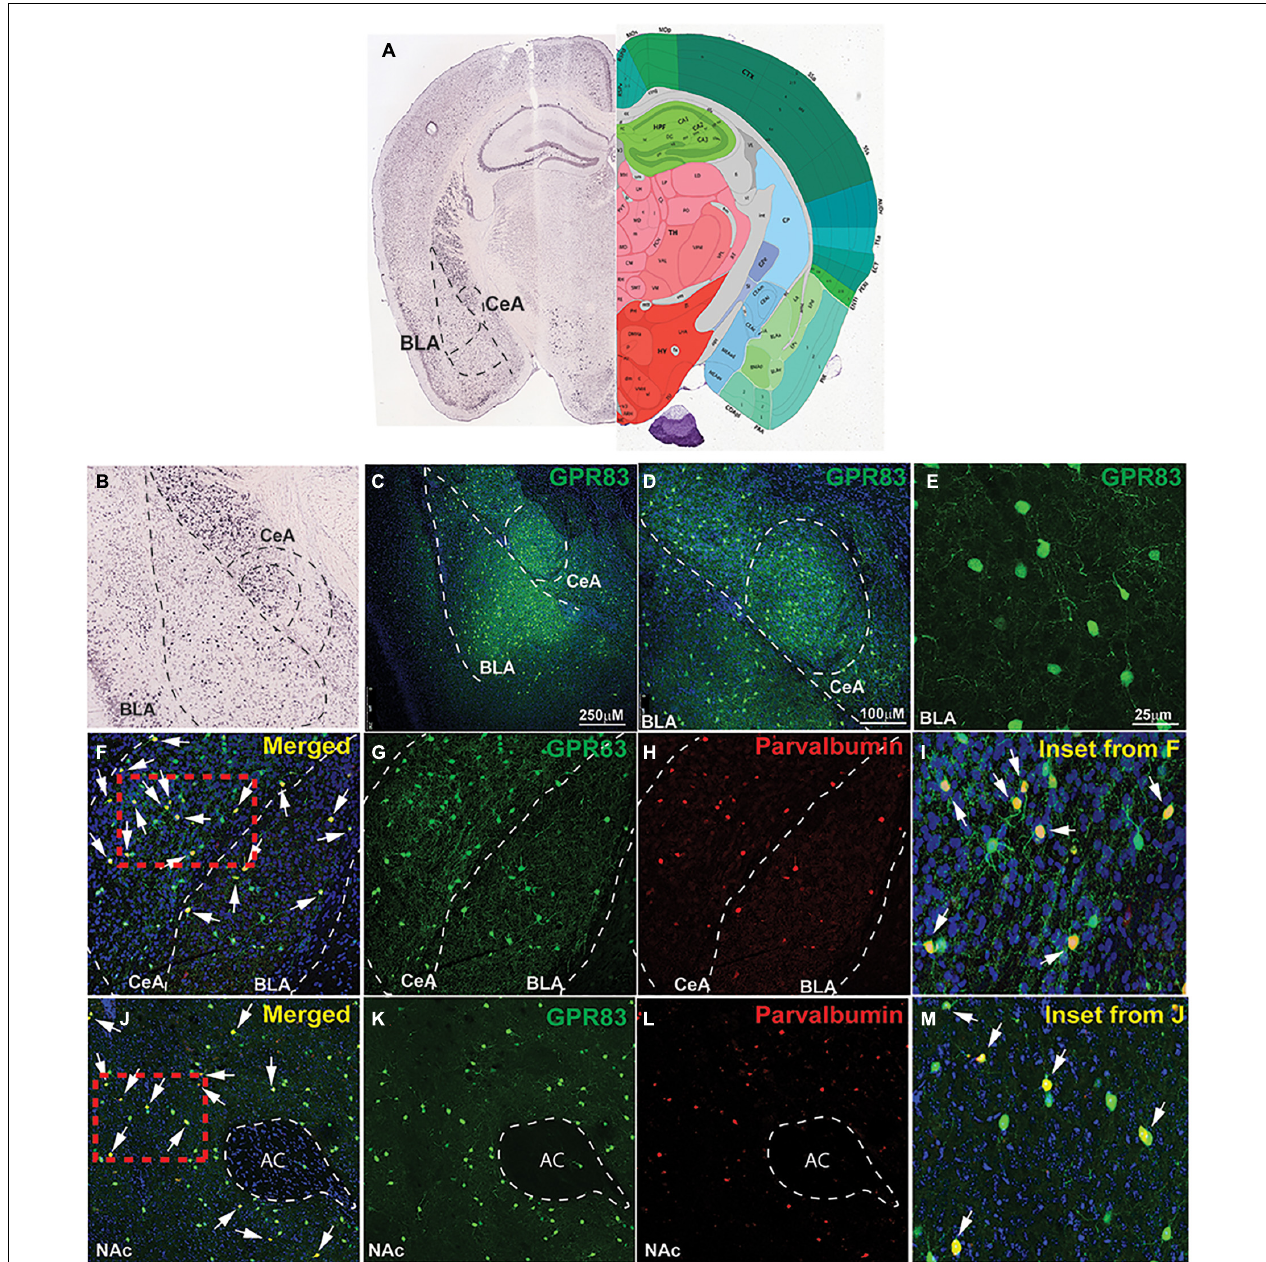
FIGURE 3 | GPR83 expression in the basolateral and central nucleus of the amygdala. (A) In situ hybridization image for GPR83 from the Allen Mouse Brain Atlas (Allen Institute. 2015 Allen Institute for Brain Science. Allen Brain Atlas API) (left) and corresponding brain atlas image (right). (B) Enlarged image of BLA and CeA shown in (A) . Low magnification image of GPR83 (green) expression in the BLA and CeA (C,D) using GPR83-GFP reporter mice from Gensat. (E) Higher magnification image showing GPR83 expression in neurons in the amygdala. (F) Co-localization (yellow, arrows) of GPR83 (green, G ) and parvalbumin (red, H ) in the BLA and CeA. (I) Inset from F . (J) Co-localization (yellow, arrows) of GPR83 (green, K ) and parvalbumin (red, L ) in the NAc. AC, anterior commissure. (M) Inset from J .